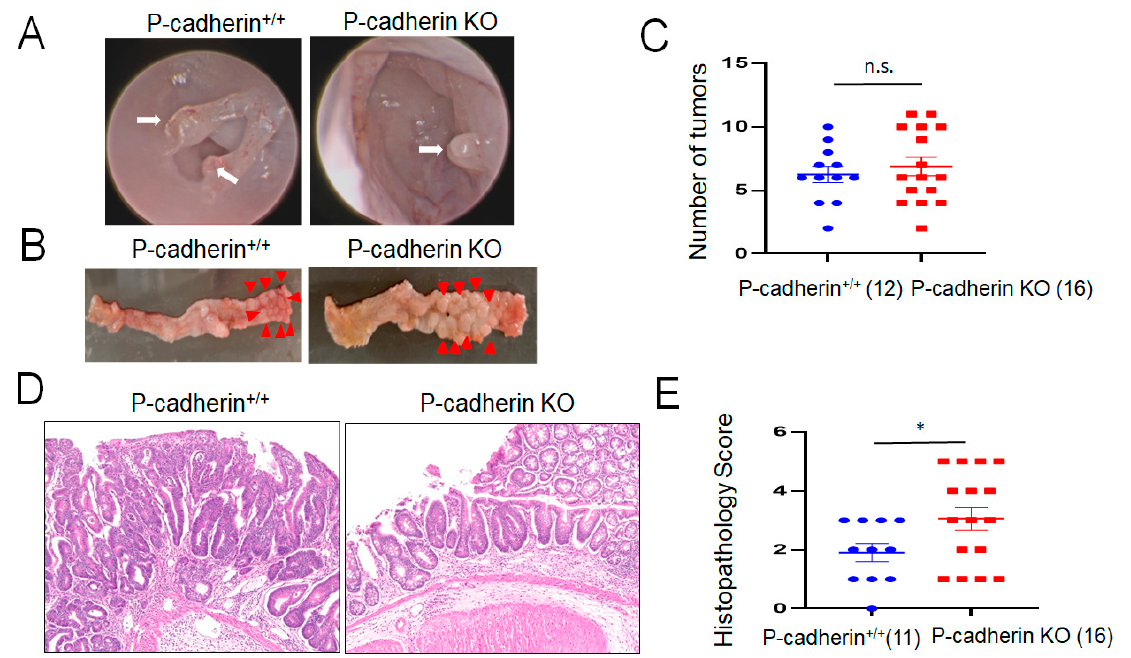
Figure 3. Development of colitis-associated colon cancer is not altered in P-cadherin knockout mice. Control and P-cadherin KO mice were injected intraperitoneally with AOM and subjected to three cycles of DSS exposure and recovery. Mice were euthanized and their colonic polyps were counted and examined. ( A ) An endoscopic view of the colonic polyps (arrows). ( B ) Overall view of the dissected colonic segments with tumors (arrowheads). ( C ) Number of developed colonic tumors. ( D ) Representative hematoxylin and eosin staining of the colonic sections showing high grade neoplasia and low grade neoplasia in control and P-cadherin knockout mice, respectively. ( E ) The histopathology score. Number of animals of each group is shown in parentheses. * p < 0.05; n.s., not significant, p = 0.594. Data were combined from two independent experiments.